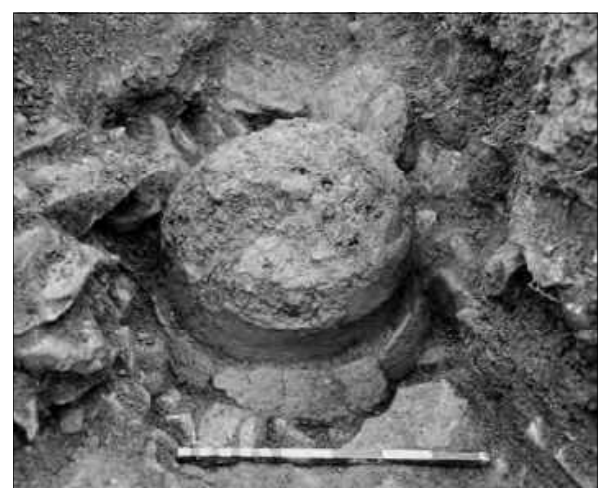
Fig 2.19 Excavation of a Bronze Age cremation urn at Al- lithwaite, Cumbria (OA